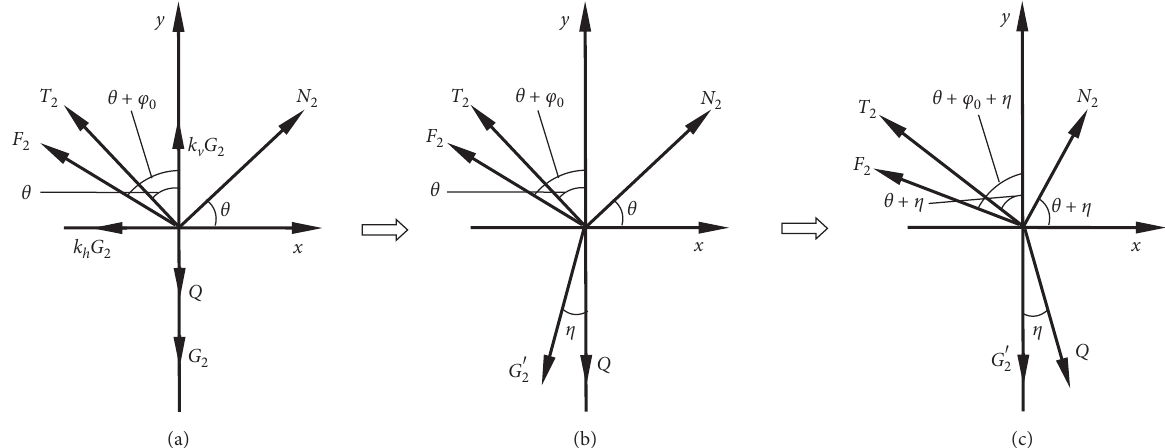
Figure 5: Calculation diagram of the side wall fractured zone. (a) Original force diagram. (b) Composition graph of inertial force and gravity. (c) Force system rotation angle η